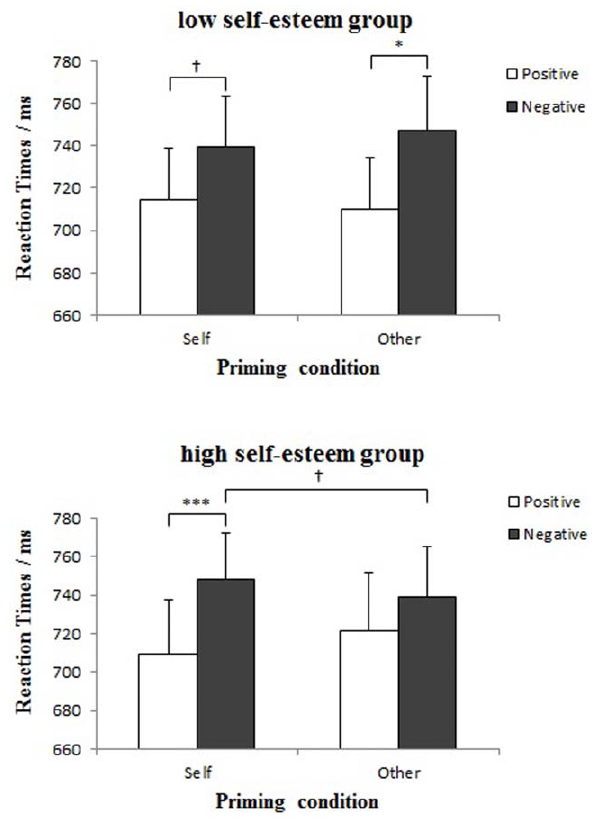
Figure 2. Mean reaction times to valenced words by face primes at different self-esteem levels. For this and the following figures, { p , .08, * p , .05, ** p , .01, *** p , .001, errors bars indicate standard